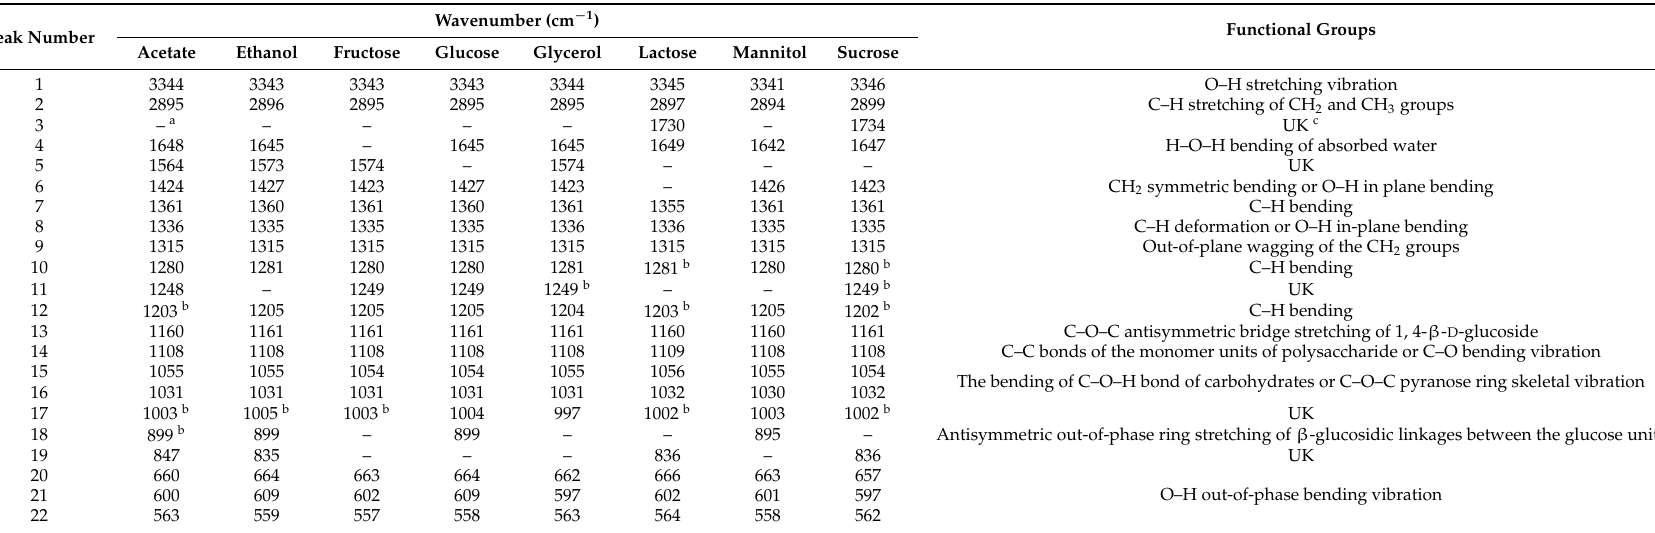
Table 3. Fourier transform infrared (FTIR) analysis of functional groups on BC produced from different carbon